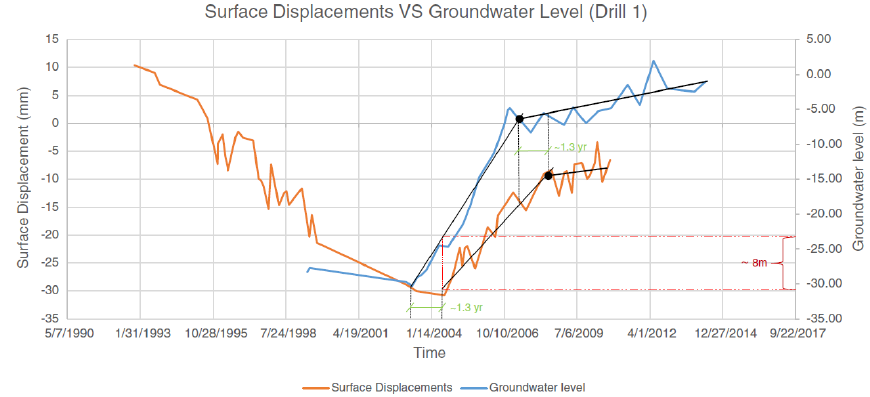
Figure 4. Graph comparing the ground water level variations at Drills 1 with the surface deformation time series at nearby data points produced by the SAR analysis (Svigkas et al.,